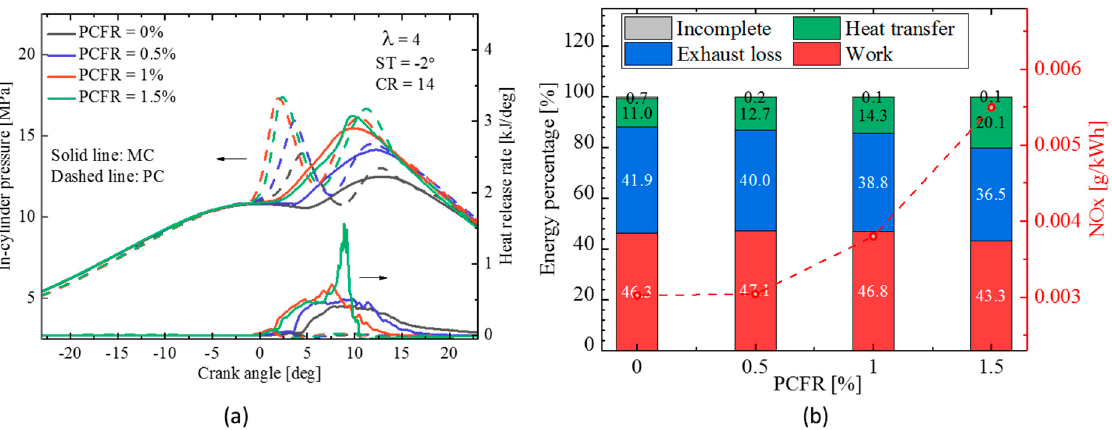
Figure 17. Predicted: ( a ) in-cylinder pressure and heat release rate traces; and ( b ) efficiency for CR = 14, and λ = 4, and ST = − 2° using different PCFRs.